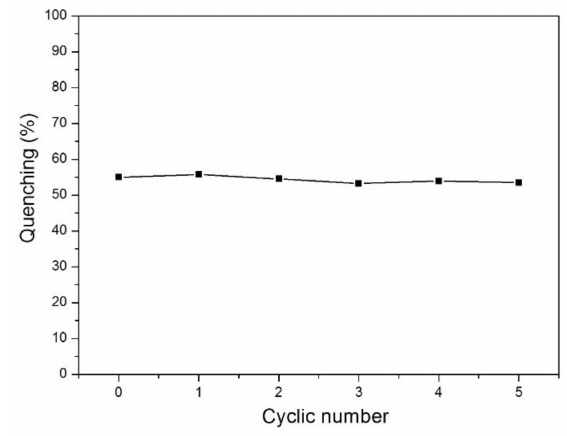
Figure 6. PL recovery cycles of n-TPE-AP-PDMS film in NB.